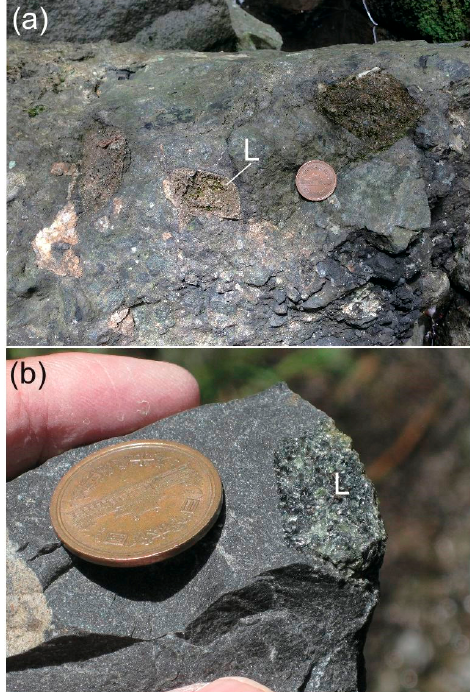
Figure 2. Photographs showing the mode of occurrence of peridotite xenoliths at Bankawa, Japan. The coin is about 2.3 cm across. ( a ) altered lherzolite xenolith (L) in the marginal breccia zone of the alkali basaltic dike; ( b ) fresh lherzolite xenolith (L) in massive alkali basalt. In the Izumi Mountains, four geologic divisions, namely the late Pliocene–early Pleistocene Osaka Group, Cretaceous Ryoke granitoids and Sennan Rhyolites, Late Cretaceous Izumi Group, and Sanbagawa metamorphic belt, have been established from north to south [26,33]. The Izumi Group unconformably caps or is bounded with faults by the Ryoke granitoids and Sennan Rhyolites in the northern margin, and is in contact with a great boundary fault, the Median Tectonic Line (MTL), in the southern margin. The Sanbagawa metamorphic belt derived from a Cretaceous accretionary complex lies in the south of the MTL. The Osaka Group unconformably overlies the Ryoke granitoids, Sennan Rhyolites and the Izumi Group. In the western part of the Izumi Mountains, the Izumi Group forms a major asymmetrical syncline named the Kyoshi Syncline [34]. Some Miocene intrusive or plutonic rocks were reported at a northern margin of the Izumi Mountains as well as along the MTL [35].